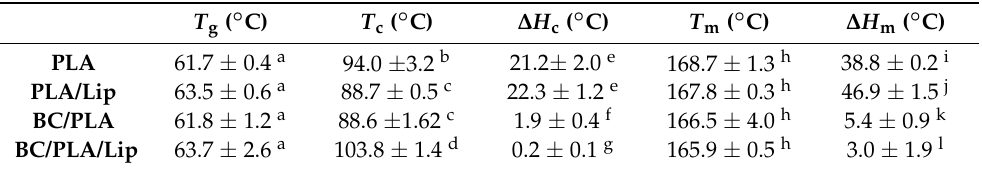
Figure 5. DSC plots of PLA ( A ) and BC/PLA ( B ) nanocomposites with and without incorporation of stearic acid. Table 1. Thermal properties of electrospun PLA and BC/PLA nanocomposites with and without incorporation of lipids.